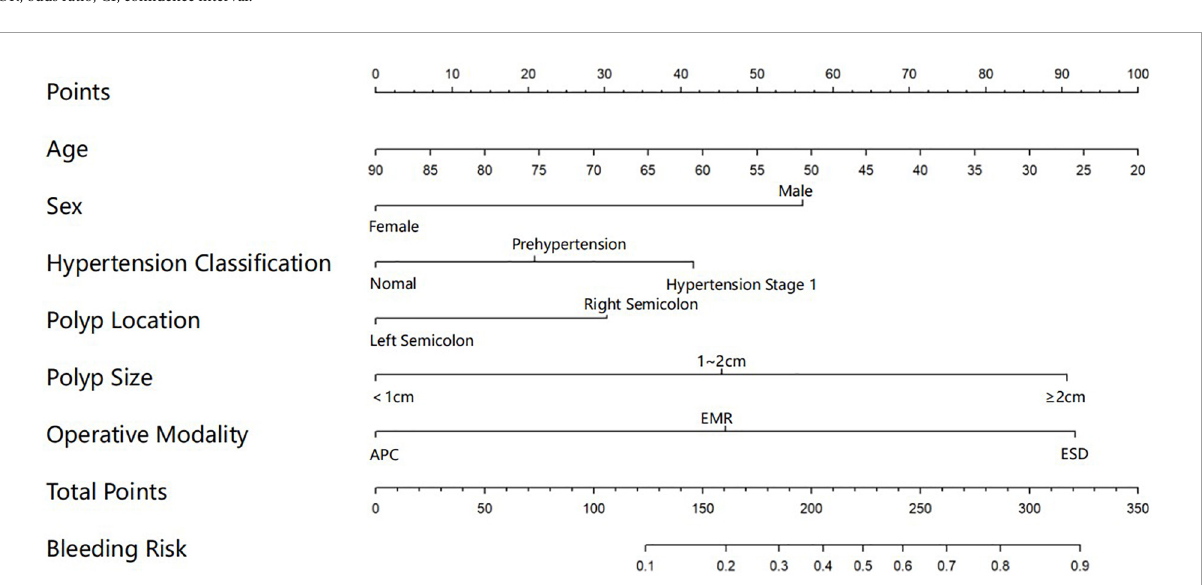
shown in Figure 2 . The optimal λ value had been selected by 10 times cross-validation, and dotted vertical lines were drawn based on the minimum criteria and one standard error of the criteria ( Figure 2A ). All these nine variables were with non-zero coefficients in the LASSO regression analysis ( Figure 2B